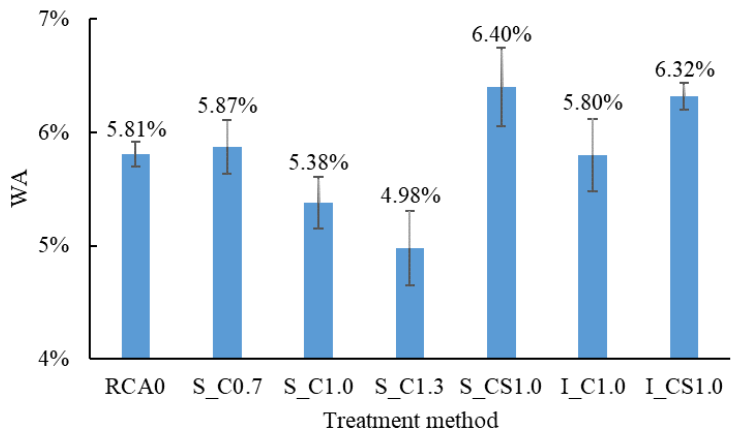
Figure 12. The results of the WA of the RCA.